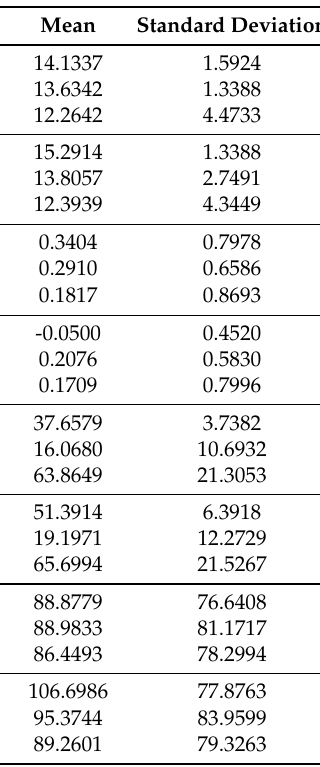
Table 1. Statistical results of traffic simulation data collected at the time of yellow